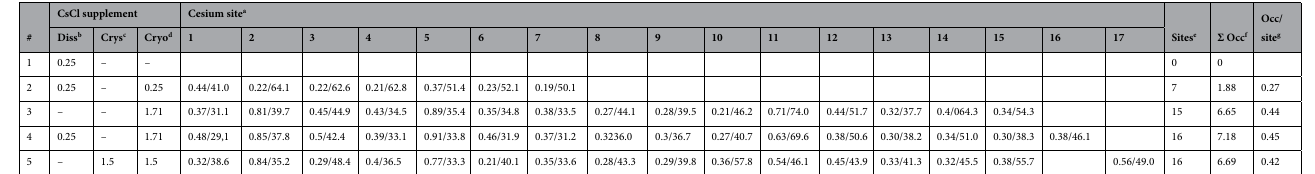
Table 5. Occurrence, occupancy and B factor of cesium sites in HEWL for the different datasets. a Occupancy/B factor of observed sites is given. Numbers correspond to sites in Fig. 3. b CsCl concentration in mol/l HEWL was dissolved in. c Supplement of CsCl to crystallization condition in mol/l. d Supplement of CsCl to cryo-protectant in mol/l. e Total number of observed sites. f Sum of occupancies of all observed sites. g Average occupancy per